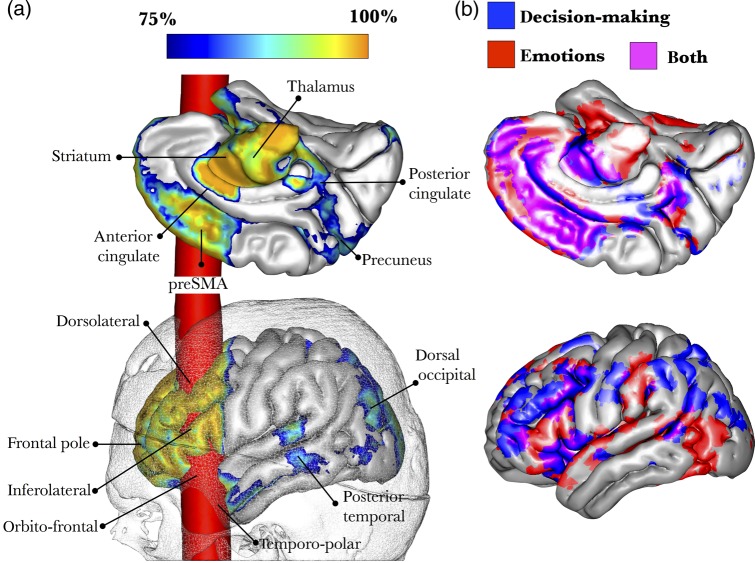
3D reconstruction of Gage's skull co-registered in the MNI space with a brain averaged from 152 subjects. (a) The trajectory of the bar through the brain is in red and shows damage to cortical areas and subcortical white matter. A blue-to-orange gradient indicates the probability of disconnection of areas not directly affected by the bar. (b) Meta-analysis of functional MRI studies reporting activations related to decision-making tasks (66 studies) and emotions (215 studies).